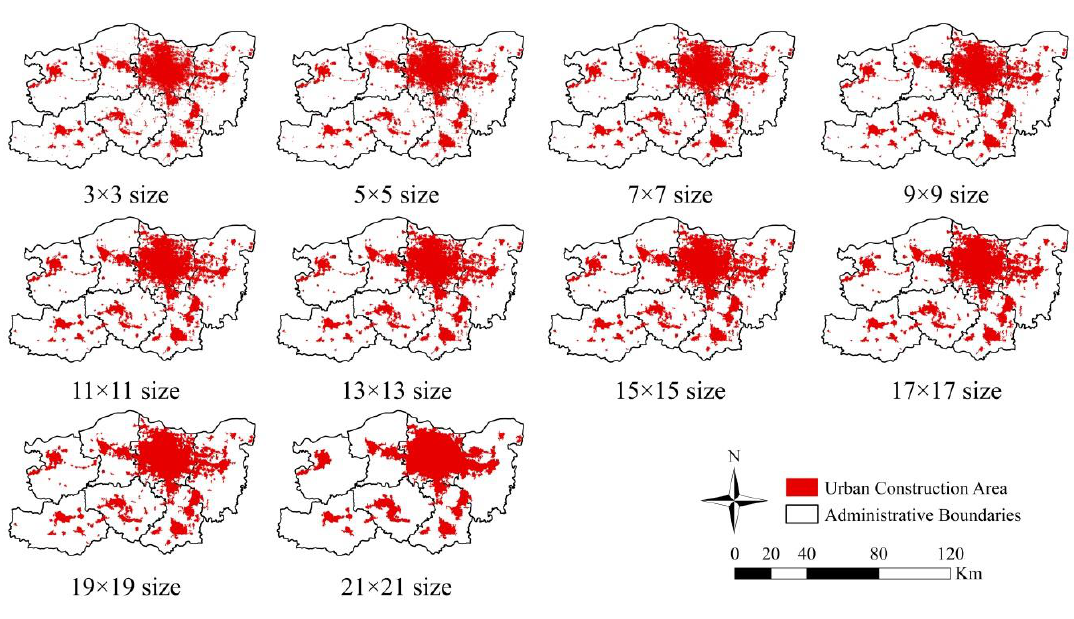
Figure 10. Di ff erent structural element size